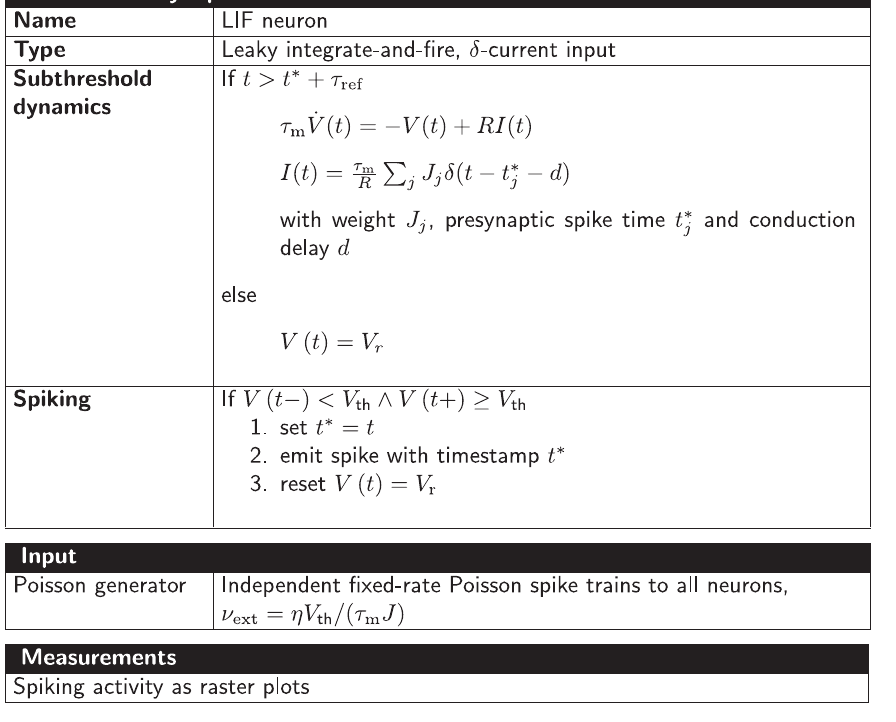
Fig 14. Continuation of Fig 13.